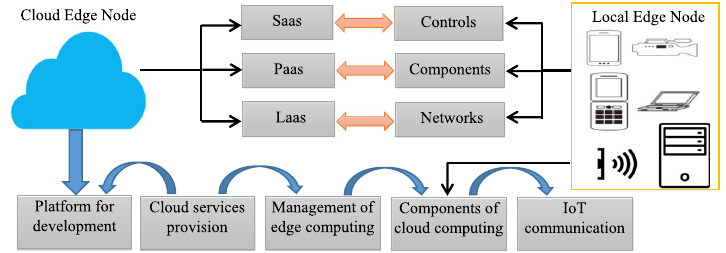
Fig. 1 Design of edge computing